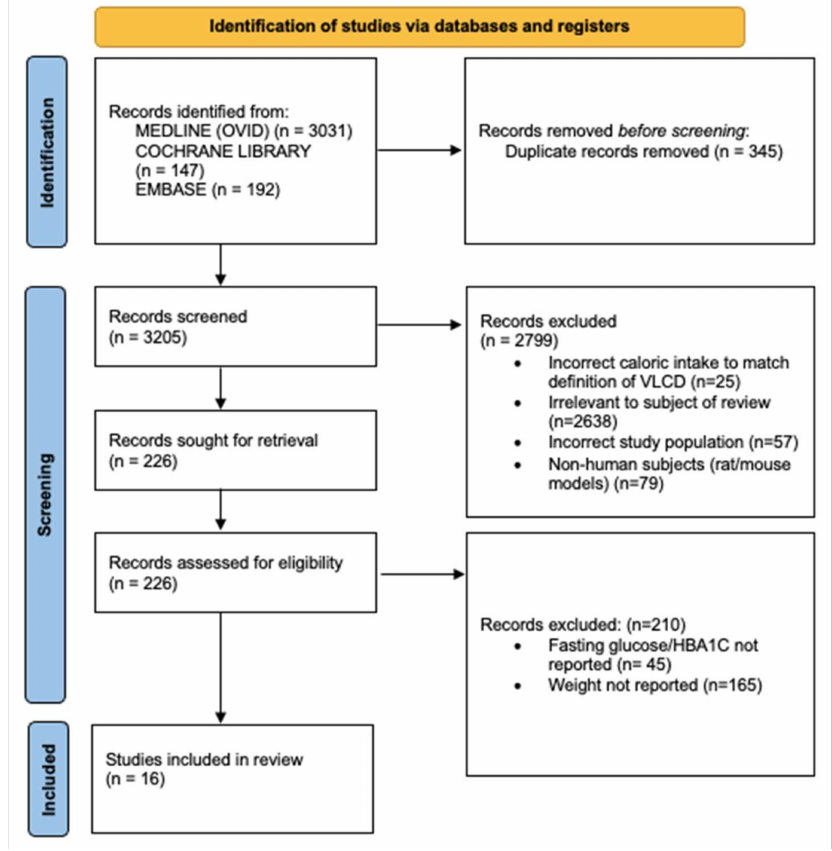
Figure 1. PRISMA illustrating the study selection